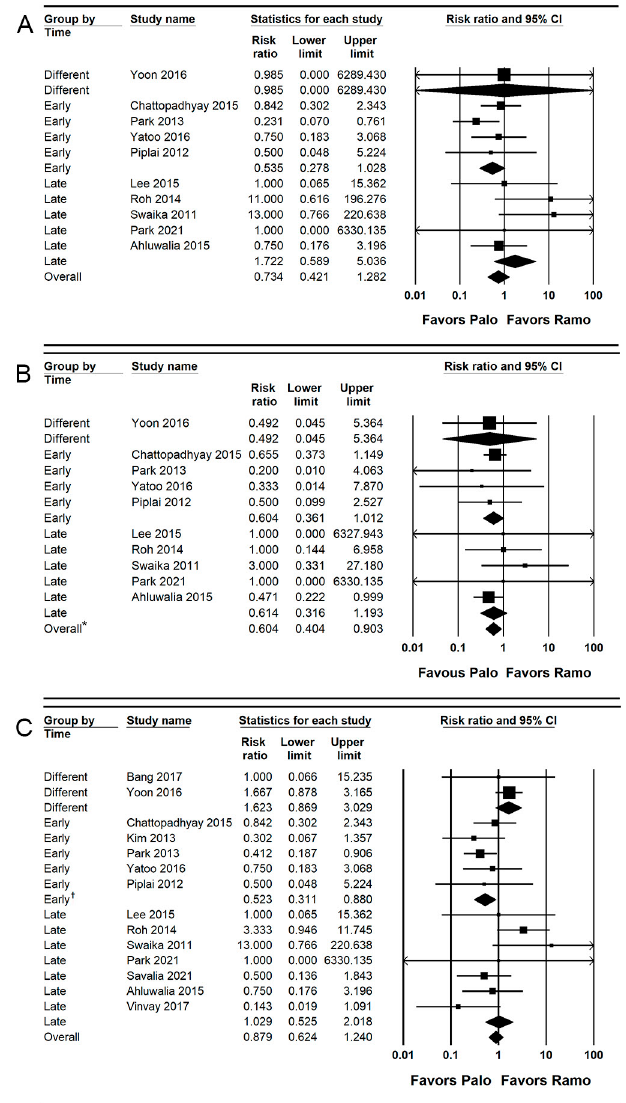
Figure 4. Forest plot of studies comparing the effectiveness of palonosetron with that of ramosetron on POV. ( A ) Early, ( B ) late, and ( C ) overall. The size of the filled squares of risk ratios reflects the effect size of individual trials. Horizontal bars represent 95% confidence intervals of difference. The diamond depicted the pooled estimates and uncertainty of the combined effect. The combined results showed no evidence of differences between palonosetron and ramosetron for early and overall POV. Notwithstanding, palonosetron was more effective than ramosetron in preventing late POV (*). For subgroup analysis, the pooled estimates of palonosetron indicated that it was more effective than ramosetron in preventing the overall POV when they were administered early (†), while the pooled estimates presented no evidence of differences between palonosetron and ramosetron when they were administered late.